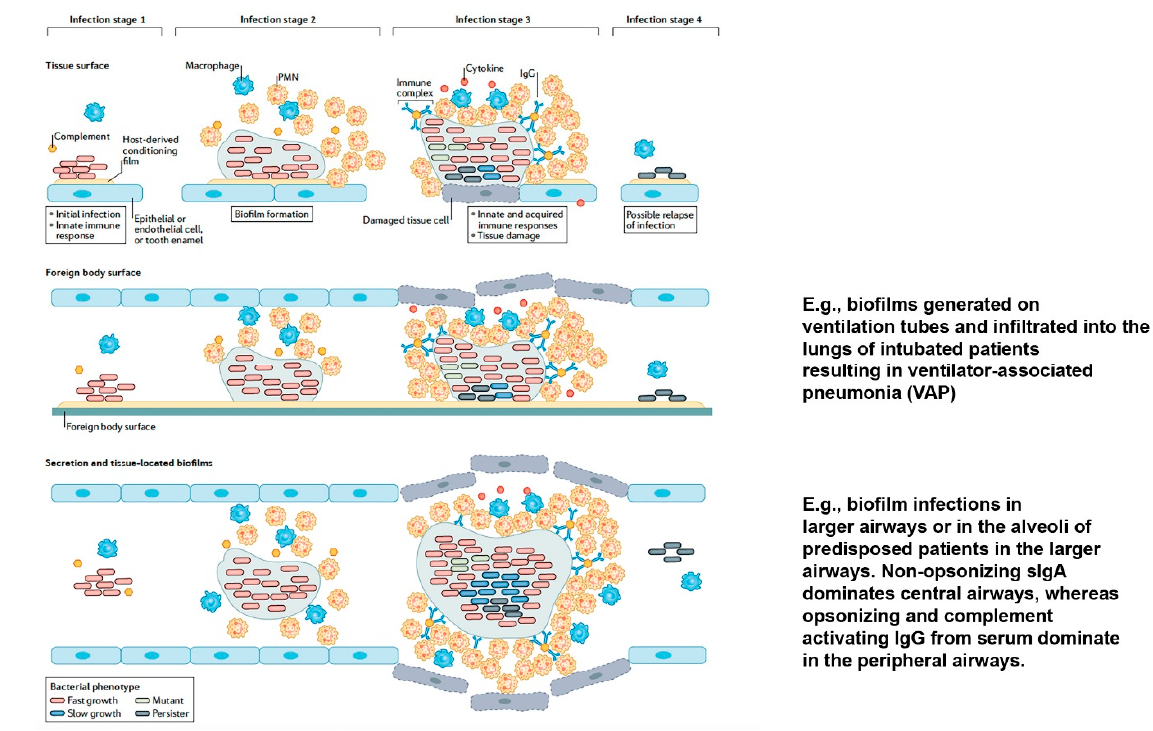
Figure 2. Graphic presentation of the tolerance of microbial biofilms to host immune responses according to the host-microbial biofilm interactions of biofilms on tissue surfaces (top panel), foreign body surfaces (middle panel) and within secretion and tissues (lower panel). The inflammatory response is demonstrated according to the distribution of macrophages and polymorphonuclear leukocytes (PMNs) in each of the four stages. Inflammation is also composed of the release of reactive oxygen species, proteases and DNA from PMNs (not indicated). In stage 1, resident macrophages and the complement system recruit PMNs and trigger an innate immune response following infec- tion. During biofilm formation in stage 2, PMNs become the dominant cell. Stage 3 is characterized by tissue damage caused by an accelerated recruitment of proteolytic PMNs due to a synergic inter- play between the innate immune response and the continual maturation of the adaptive immune response. The matured biofilm is characterized by a heterogenic bacterial population consisting of bacterial cells with variable growth rates, dormant and persister cells (slow growing), which are tolerant to the immune response. Mutants, including antibiotic-resistant isolates, also occur. The host response may effectively diminish the pathogenic biofilm and the subsequent dispersed bacte- ria to low levels, whereby the continual stimulation of the immune response and succeeding sys- temic signs of infection is annulled (stage 4) (reproduced with permission from Ref. [7], copyright 2022 Springer Nature). The consequences of biofilm formation encompass recalcitrance to antimicrobials and the effector functions of the immune system. Recently, the biofilm tolerance and re- sistance mechanisms were thoroughly reviewed and will not be described in detail in the present review [7]. 3. Biofilm and Initiating the Immune System The initial immune reaction to established biofilm infections is delivered by the in- nate immune system, which non-specifically attacks entering microorganisms [13,14].